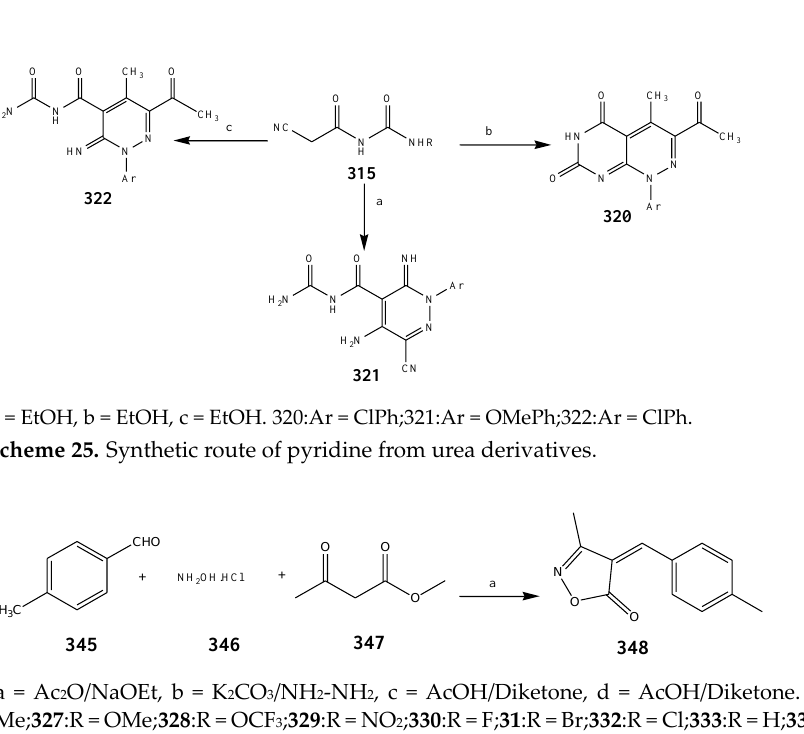
Scheme 26. Synthesis of 3-amino-6-(trifluoromethyl)-1 H -pyrazolo[3,4- b ] pyridine-5-carboxylate.